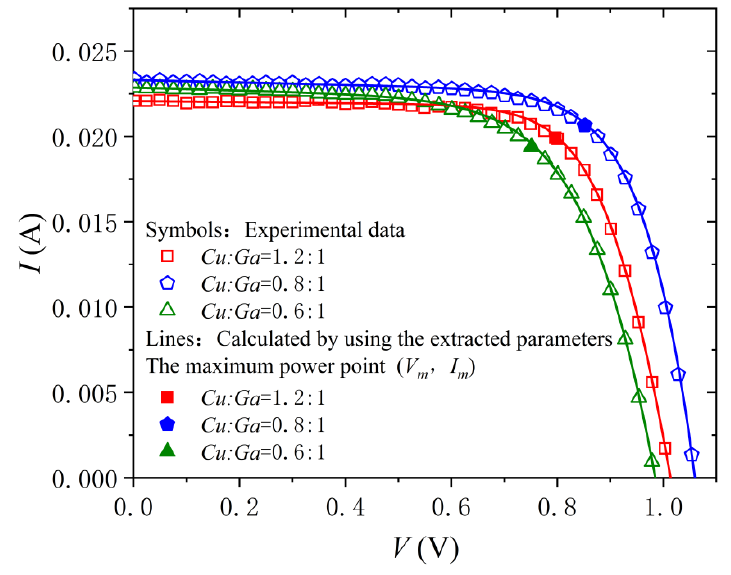
Figure 4. I-V characteristics measured and calculated, respectively.